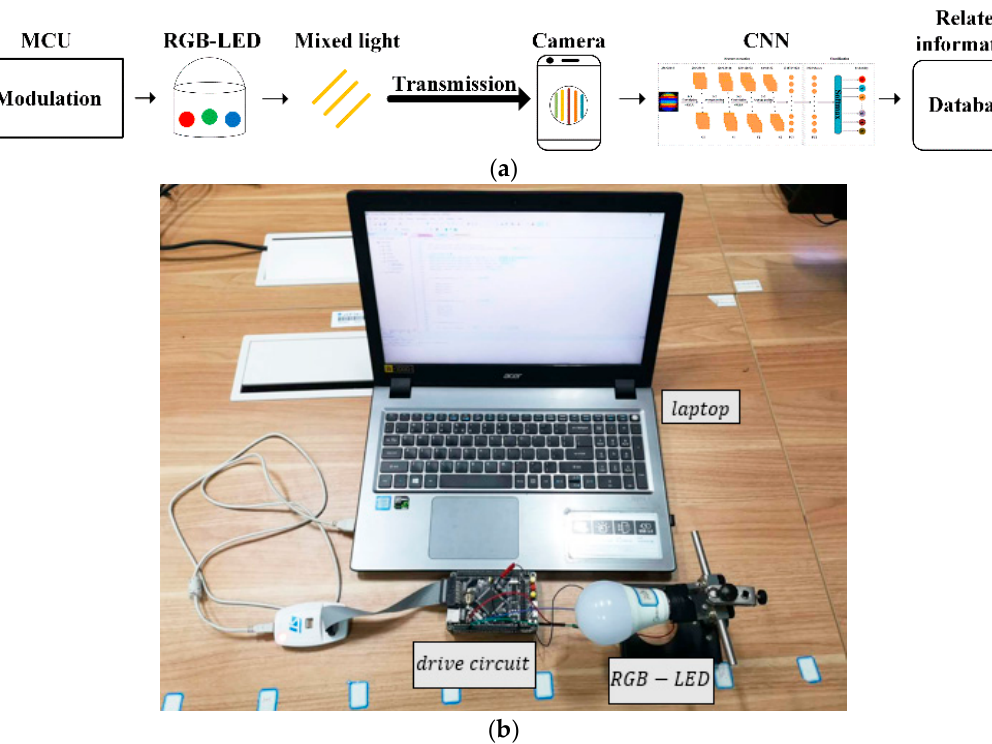
Figure 7. ( a ) System overview. ( b ) Experimental setup